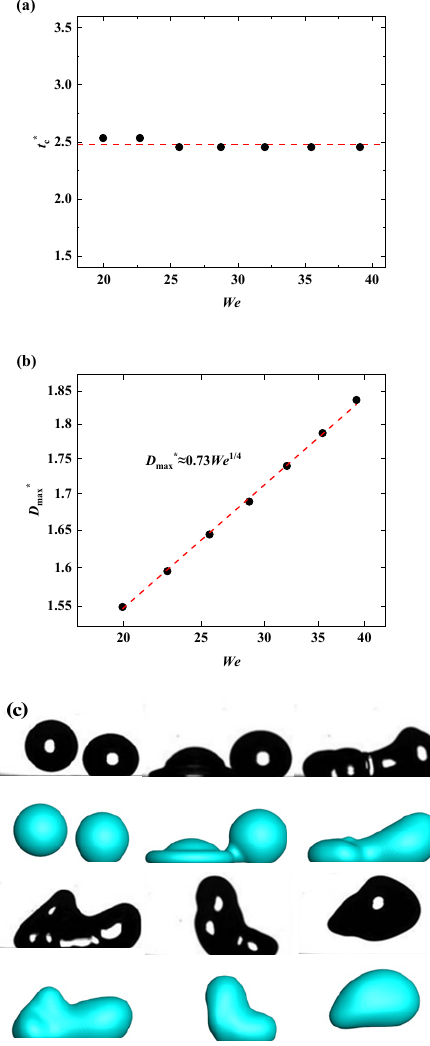
Figure 1. The model validation. ( a ) The dimensionless contact time as a function of We . ( b ) The dimensionless maximum spreading diameter as a function of We . ( c ) The dynamic behavior of a failing droplet impacting a stationary droplet on a superhydrophobic surface with L x * = 1.1, and We = 21.8.